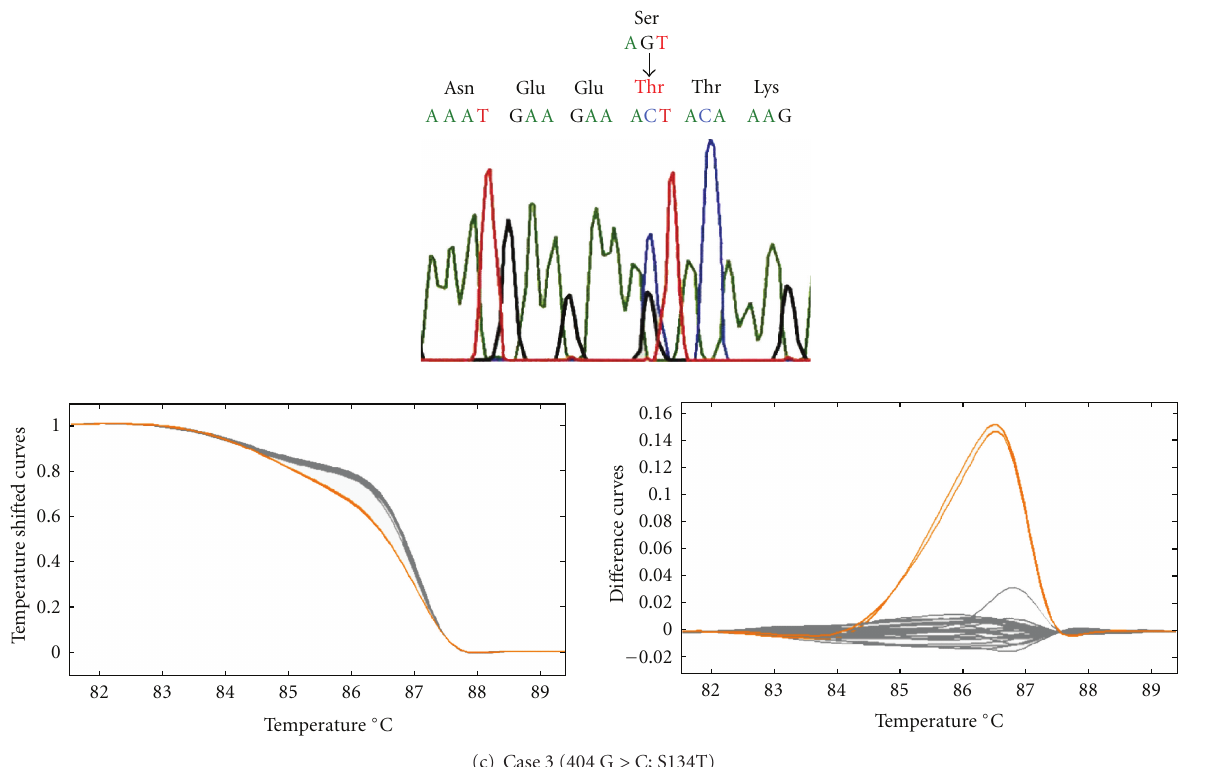
Figure 2: Sequence (upper), melting curves (left lower) and subtractive fluorescent di ff erence plots (right lower) of the three novel